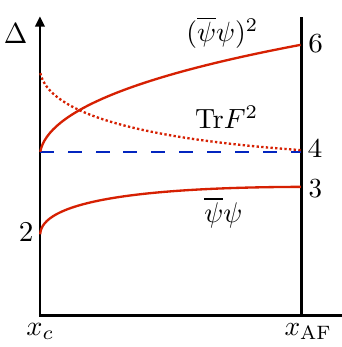
Figure 10 . Schematic behavior of the operator dimensions at the BZ (cid:12)xed point as a function of x = N f =N c , at N c = . The dimension of ( (cid:22) ) 2 is twice that of (cid:22) . All dimensions have a 1 square-root singularity at x = x c